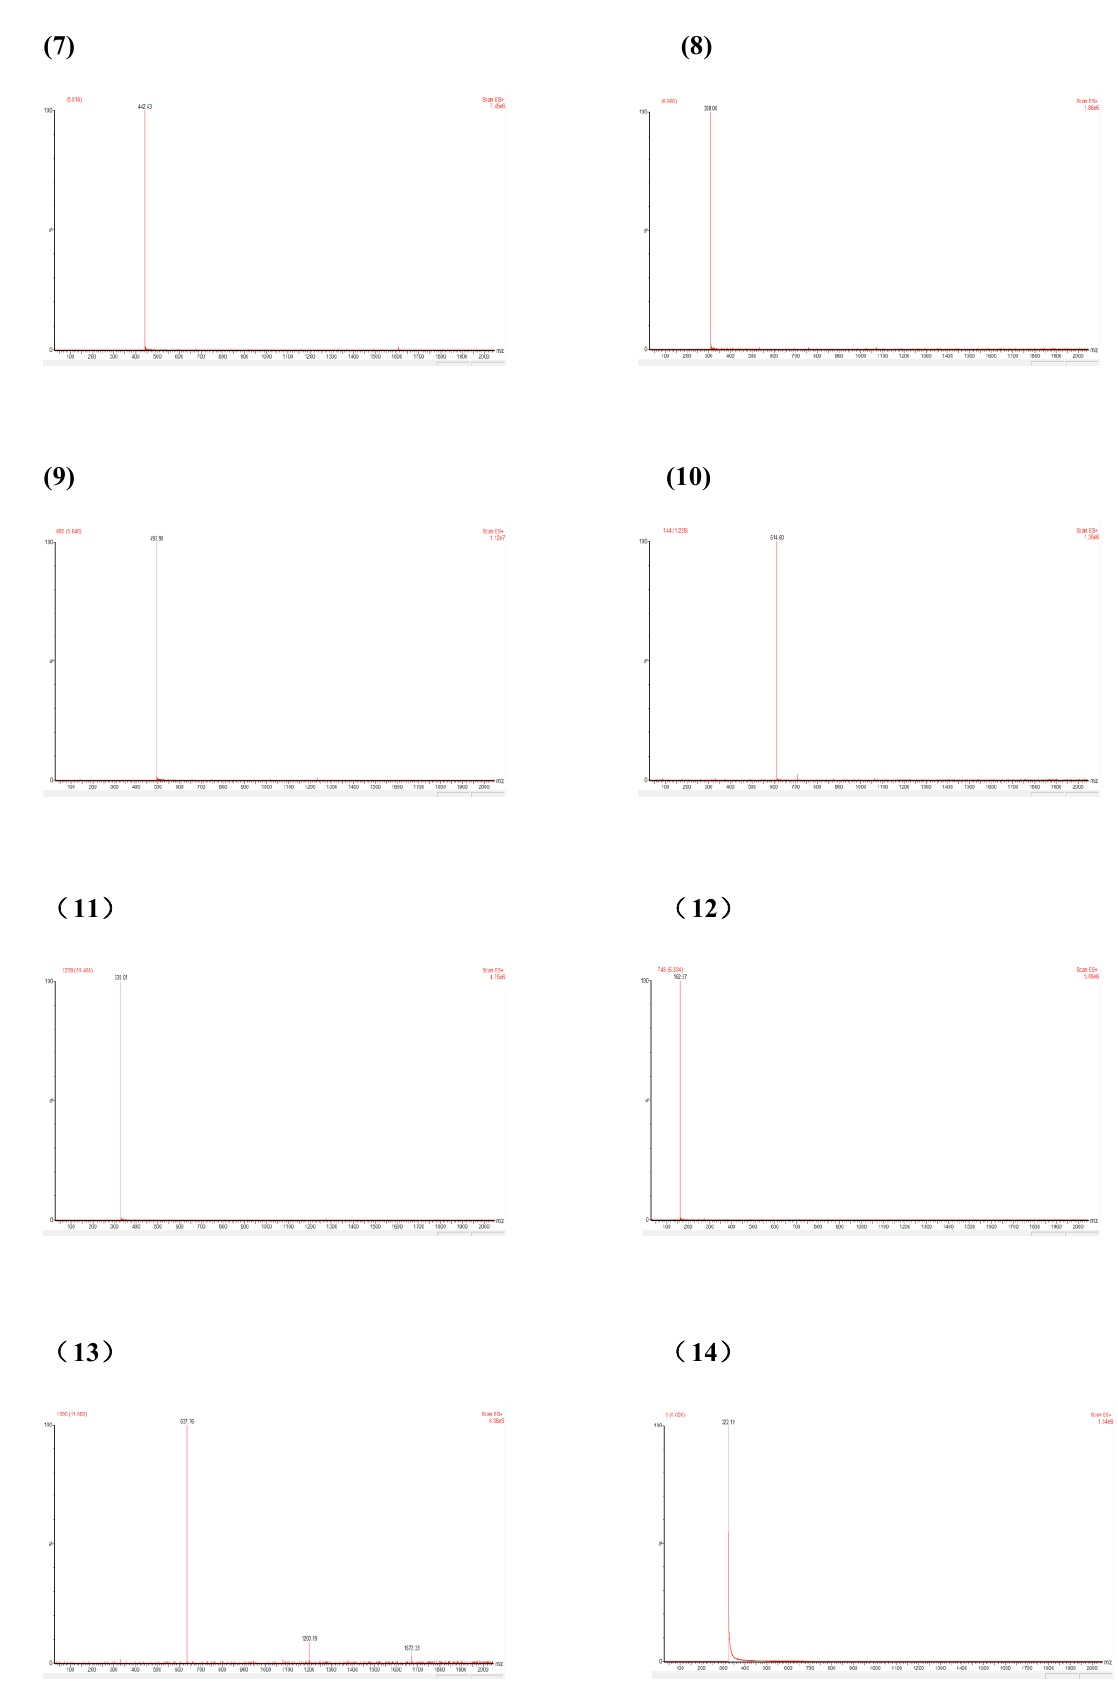
Fig. 3. HPLC-MS/MS chromatograms of MF polyphenols extract and analysis mass spectrum of 461 the sixteen phenolic compounds.